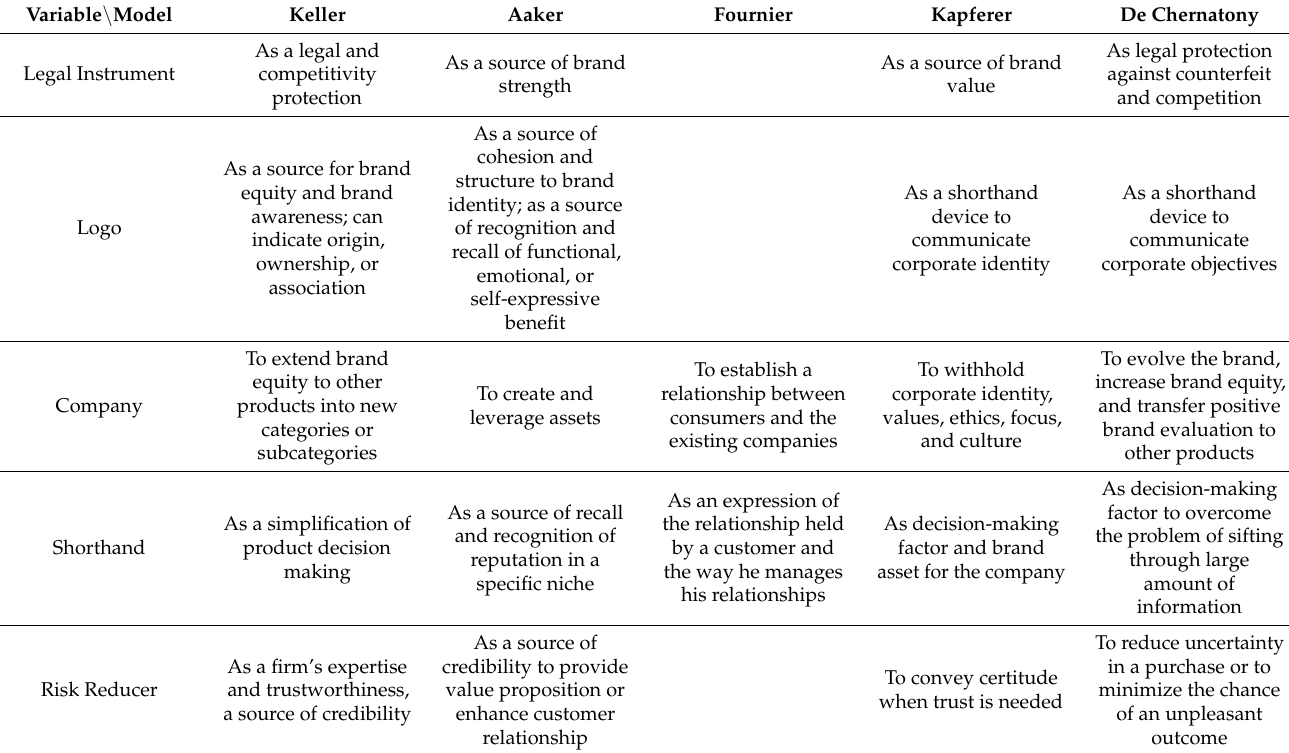
Table 1. Review of the 12 dimensions that define a brand according to Keller [13], Aaker